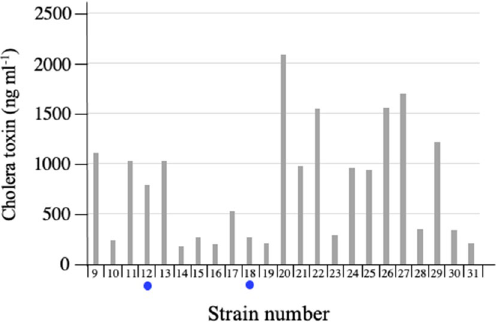
Figure 1. Amount of cholera toxin produced by V. cholerae O1 isolated from patients with diarrhea. Twenty- three strains of V. cholerae O1 were isolated from 23 patients with diarrhea. These isolates were cultured statically in AKI medium 7 at 37 °C for 24 h. After removing the cells by centrifugation, the CT in the culture supernatants was measured using a GM1-ganglioside ELISA method 8 . The samples indicated by blue circle